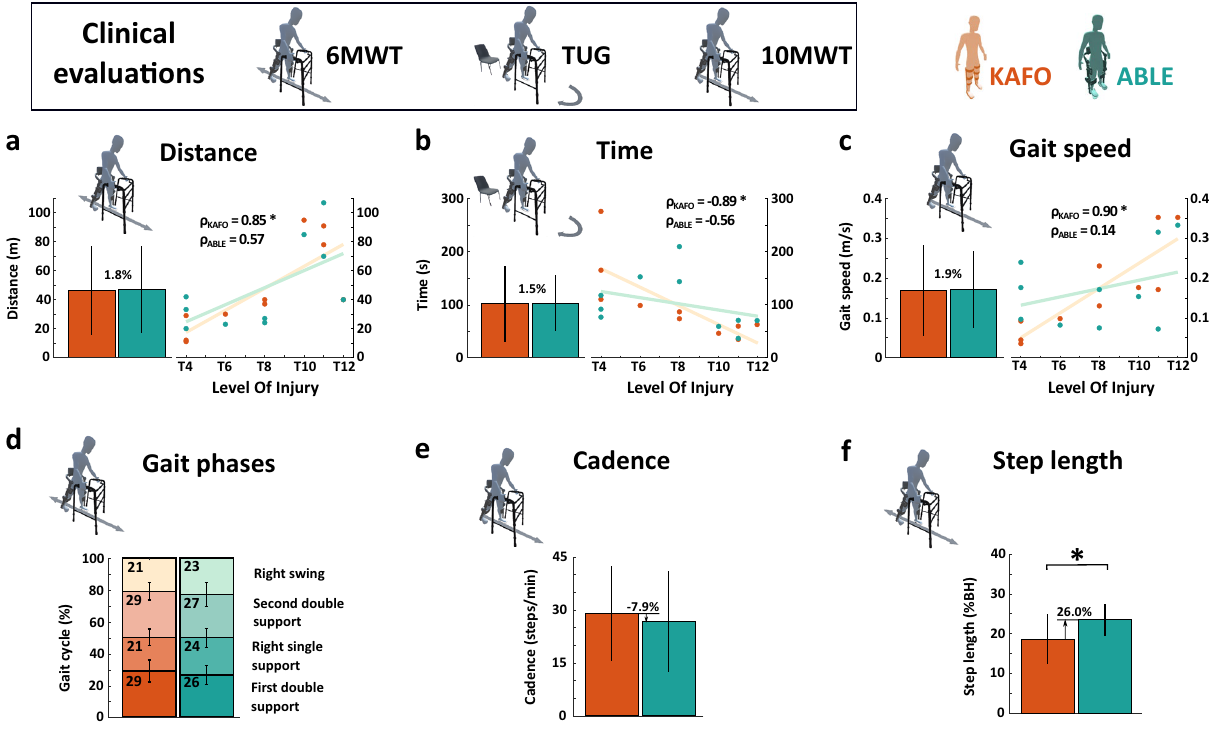
Figure 2. ( a ) Distance covered during the 6 MWT. ( b ) Time needed to complete the TUG. ( c ) Gait speed during the 10 MWT. ( d ) Gait phases during the 6 MWT. ( e ) Cadence during the 10 MWT. ( f ) Step length in % of body height (%BH) during the 6 MWT. Bar plots show the mean and standard deviation from all the participants. The correlation was measured with the Spearman correlation coefficient ( ρ ). Stars (*) indicate statistically significant differences ( p < 0.05